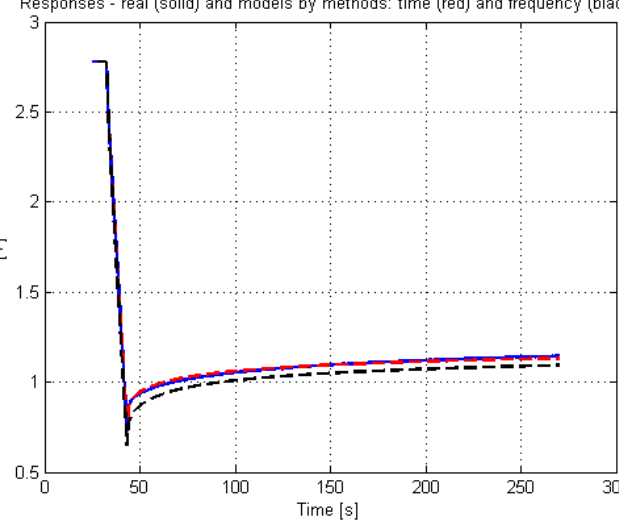
Figure 14. The voltage response of 10 F SC to trapezoidal current pulse (solid line) and responses of models determined by frequency (black dashed line) and by time (red dashed line) methods.